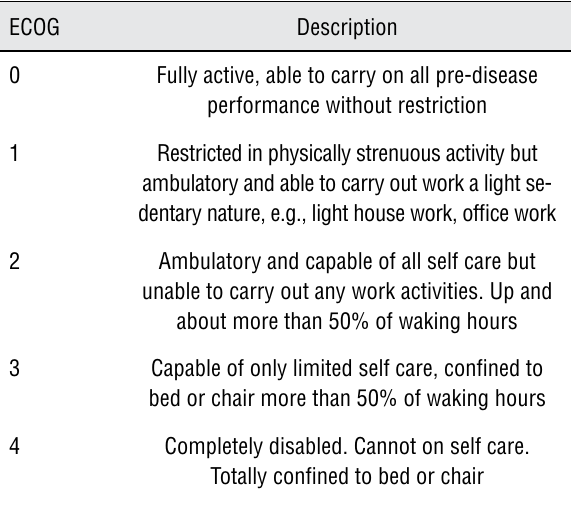
Table 3 - ECOG – PS Eastern Cooperative Oncology Group performance status.